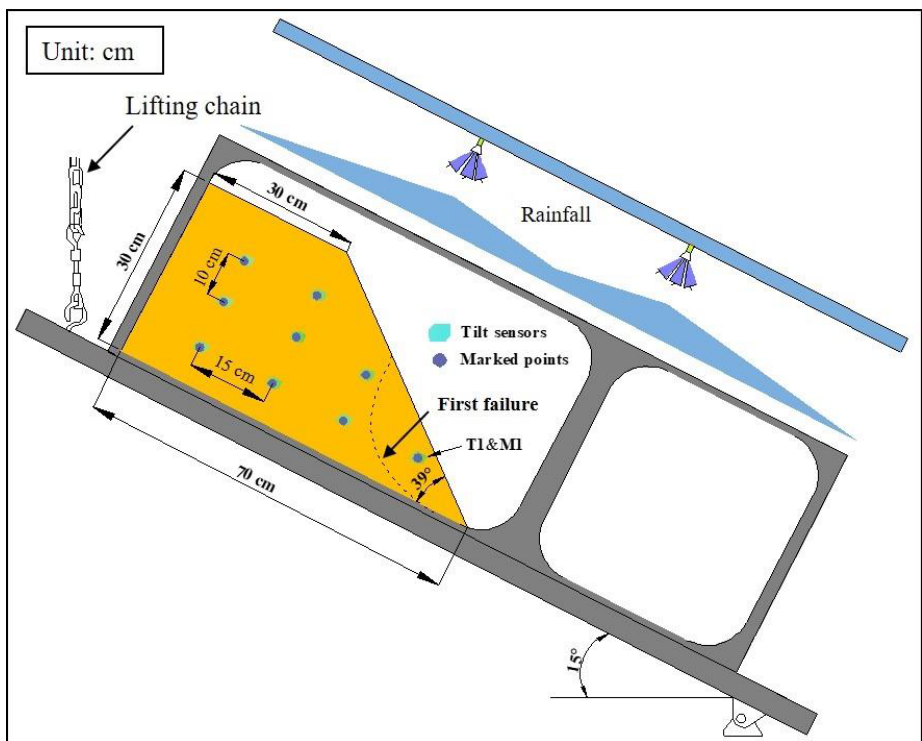
Figure 3. Illustration of the arrangement of instruments in Model Test 2.